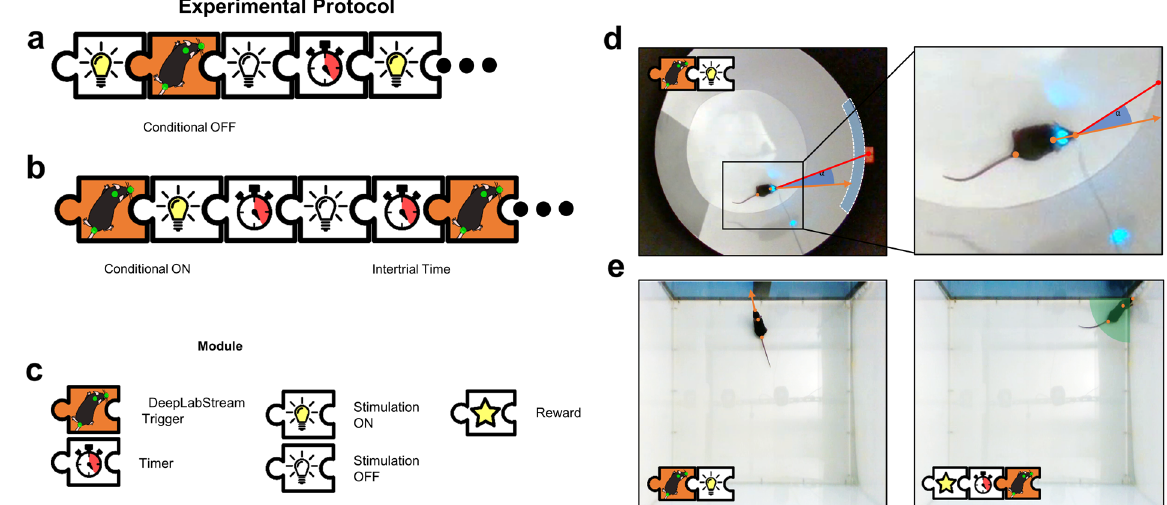
Fig. 2 Experimental design using DLStream. a , b Schematic design of an experimental protocol with a posture-based trigger. Manipulation can be turned “ Conditional OFF ” ( a ) and “ Conditional ON ” ( b ) based on the mouse ’ s behavior. The combination of several modules allows building a sophisticated experimental protocol. For example, the timer module can be utilized to design inter-trial and -stimulus timers ( b ), minimum stimulation ( b ), or delayed triggers ( e ). c Description of available modules in a and b . d Application of the above-described design in an optogenetic experiment. The stimulation is triggered dependent on head direction angle (orange arrow, α ) to a reference point (red line) within the target window (blue arc). e Application of the above-described design in a classical conditioning task. The mouse is shown an image when looking at the screen (left) and the reward is removed if it does not move into the reward location within a prede fi ned timeframe (right, green zone). The mouse ’ s posture is shown with orange